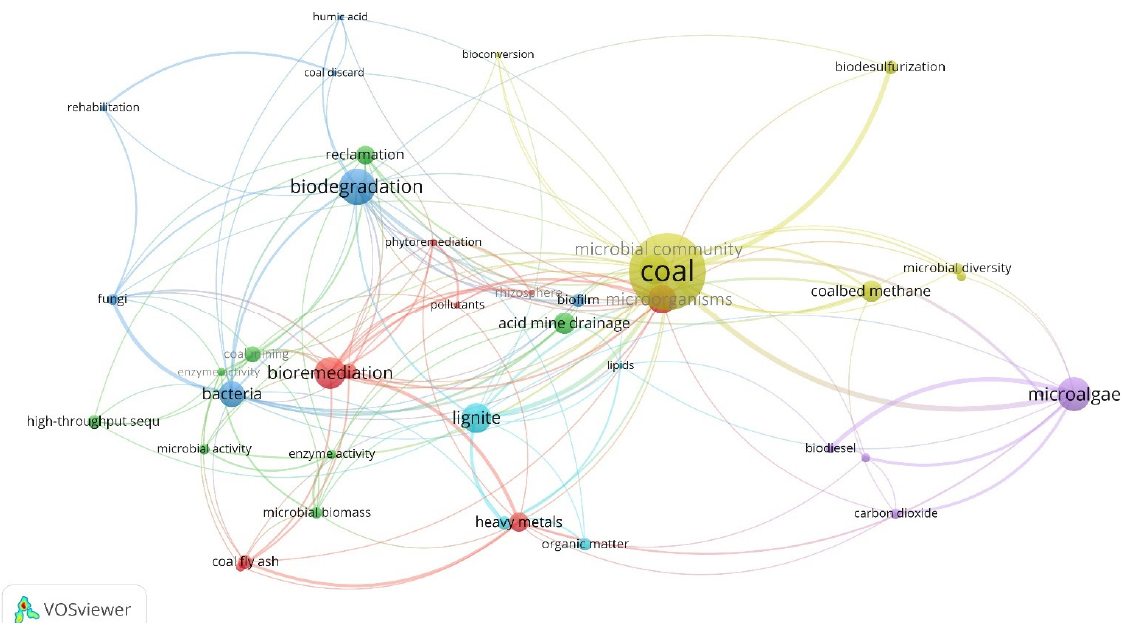
Figure 1. Keyword co-occurrence network visualization map for publications involving “coal* OR low-rank coal* OR lignite*” and “microorganisms* OR microbes*”. Only publications from 1980 to June 2022 were considered. After exporting the publications from the Scopus platform in RIS form, they were analyzed using the keyword co-occurrence function of the VOSviewer software. Here, the top 30 items in terms of the number of occurrences are shown; different circles in the figure represent keywords, and their size indicates the number of times the keywords appear. The lines between the circles indicate that two keywords have appeared together in an article, and the more times they appear, the thicker the line is. On this basis, the main aspects of coal microbiology involve substrates (coal, lignite, low-rank coal, soil, flue gas, and heavy metals), microorganisms (bacteria, microalgae, fungi, and microbial diversity), processes (biodegradation, bioremediation, and biodesulfurization), environments (acid mine drainage, coal mining, wastewater, and sewage sludge), and products (methane, biofuel, and organic matter). By selecting the keyword “microalgae”, as an example, we could observe the connection between this and other keywords, such as coal, flue gas, carbon dioxide, biodiesel, biofuel,